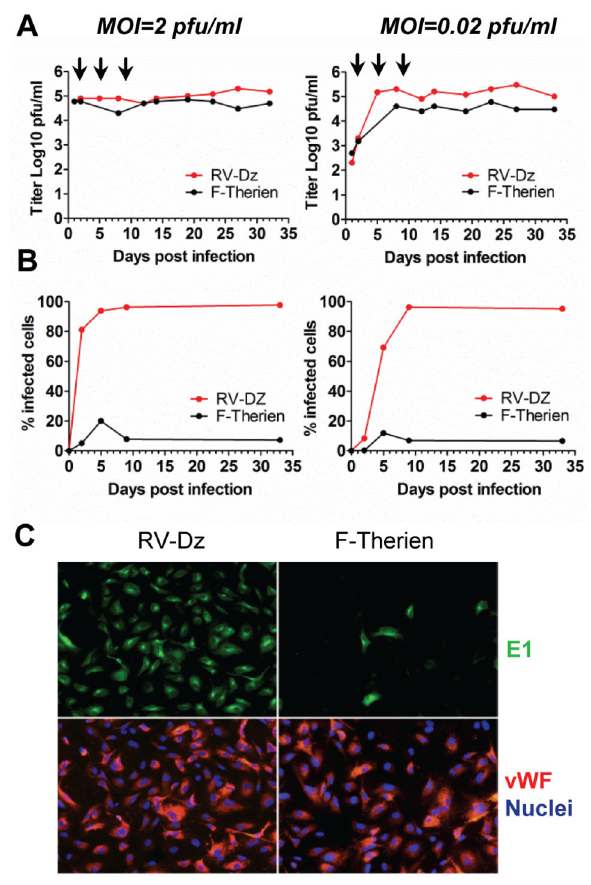
Figure 6. RV persistence after sequential passages of infected HUVEC. Cells infected at low and high MOI were passaged 1:4 at 3, 5 and 9 dpi (indicated by the arrows). ( A ) Media were changed every 2-3 days and titer of extracellular virus was determined by titration on Vero cells. The data are representative results of 2 independent experiments. ( B ) After each passage, the number of the infected cells was determined by counting E1-positive cells after IFA staining of infected cells for E1, endothelial cell marker (vWF) and counterstaining for nuclei (DAPI). ( C ) The representative results of IFA staining of the infected cells immediately after the third